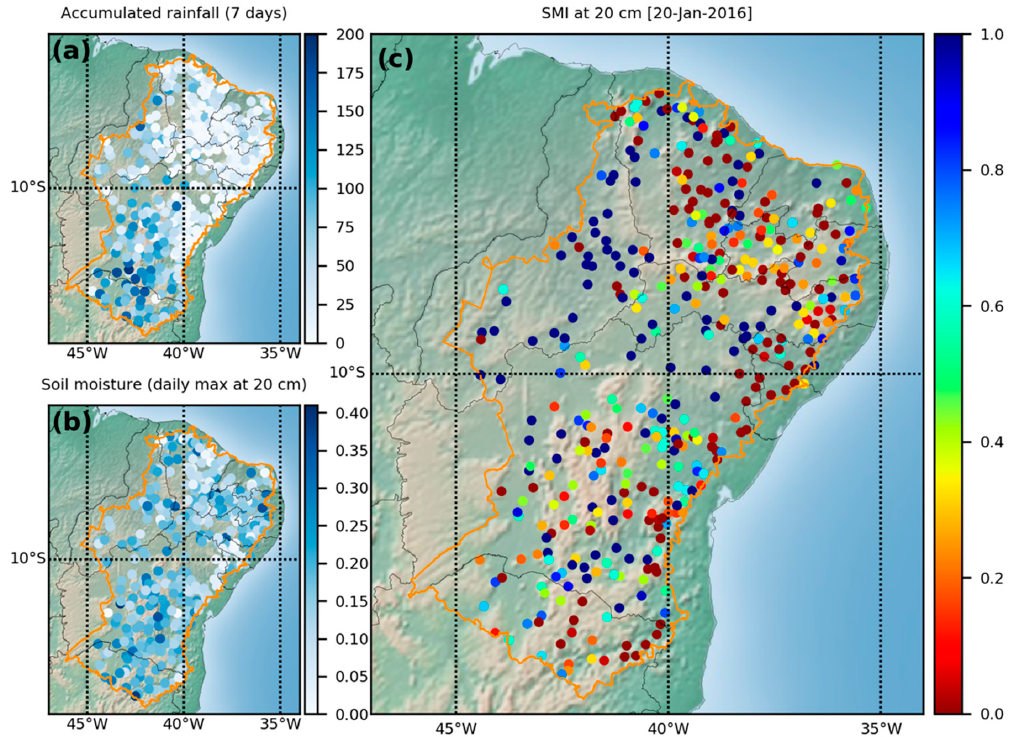
Figure 5. ( a ) Accumulated rainfall (seven days); ( b ) daily maximum of soil moisture at 20 cm (m 3 m − 3 ); and ( c ) Soil Moisture Index (SMI) for 20 January 2016.